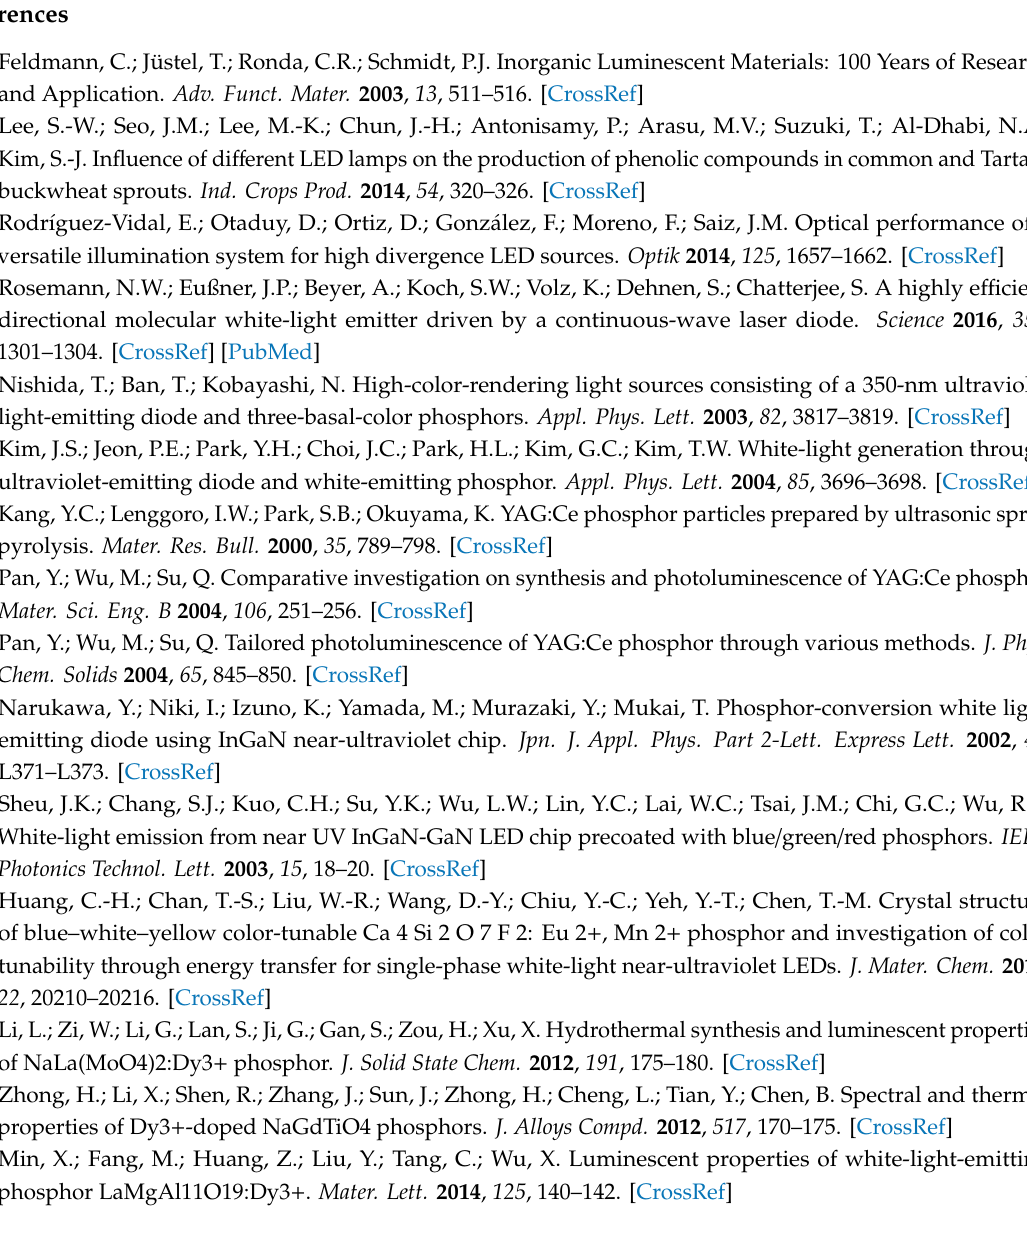
= 1, 2, 3, 5, 7) phosphors; (f) variation of the emission intensity with respect to the concentration of Tm 3 + ions; (g-h) PLE and PL spectra of phosphors NGT: z %Sm 3 + ( z = 1, 2, 3, 4, 5); (i) variation of the emission intensity with respect to the concentration of Sm 3 + ions; Figure S2: The overlap between PL emission spectrum of NGT: Dy 3 + phosphor and PL excitation spectra of NGT: Sm 3 + ; Figure S3: Comparison of the CIE chromaticity diagram of the WLED phosphors in previous literatures; Table S1: CIE coordinates of the as-prepared phosphors; Table S2: Fitting parameters of the PL decay curves; Table S3: Comparison of the CIE coordinates of the WLED phosphors in previous